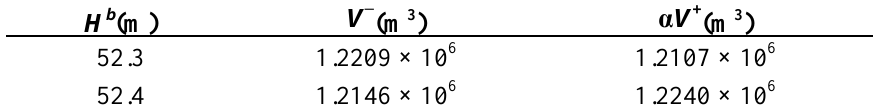
Table 4. The final two pairs of V − and αV + Values at Mass Balance Model (MBM)